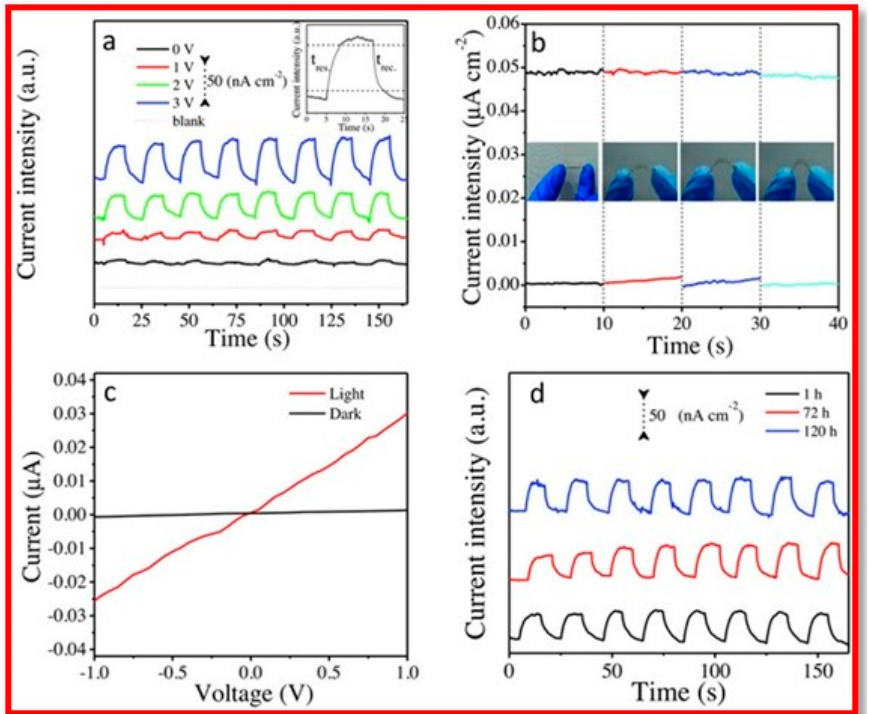
Figure 17. ( a ) Photocurrent density under different potential of BP/P([VPIm]TFSI)-based photodetectors. Inset graph is the enlarged view of the photocurrent response for rise and decay times. ( b ) The flexibility of BP/P([VPIm]TFSI) nanosheets-based photodetectors under a bias voltage of 3 V. Photocurrent density of the photodetector when bent it at different curvatures. The insets photographs indicated the corresponding bending states of the device. ( c ) Performances of BP/P([VPIm]TFSI) based photodetectors. I–V characteristics of the photodetector in the dark and under irradiation with a Xe lamp (20 mW cm − 2 ). ( d ) Stability test of the photodetector (1, 72, and 120 h). Copyright